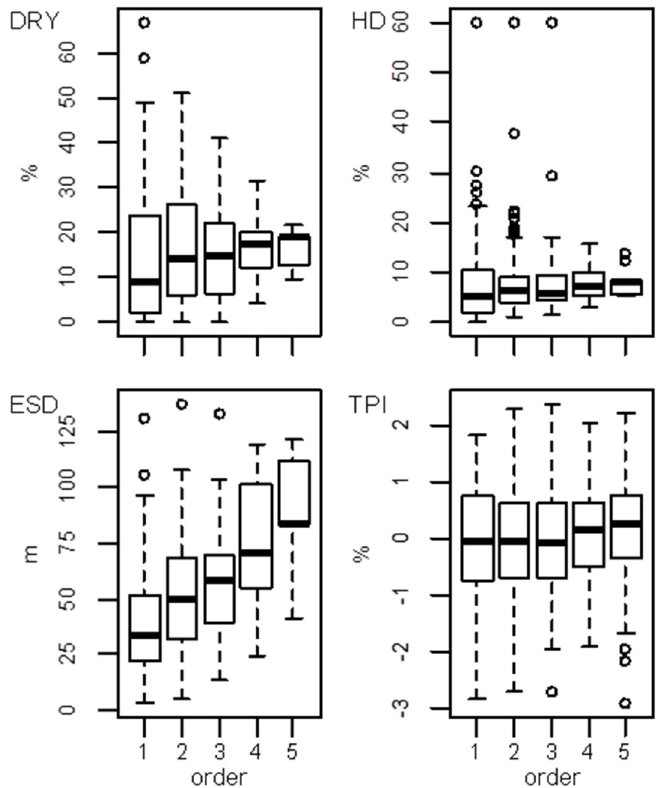
Figure 3. Dry surface deposits density (DRY) (%), Hydrographic density (HD) (%), Elevation Standard Deviation (ESD) (m) and Topographic position index (TPI) (%) distributions (see Table 1) for Orders 1–5 (see Figure 2). Horizontal lines represent the 25th, 50th and 75th percentiles, and whiskers indicate the range. Dots represent values for which the distance from the box is 1.5-times greater than the length of the box.